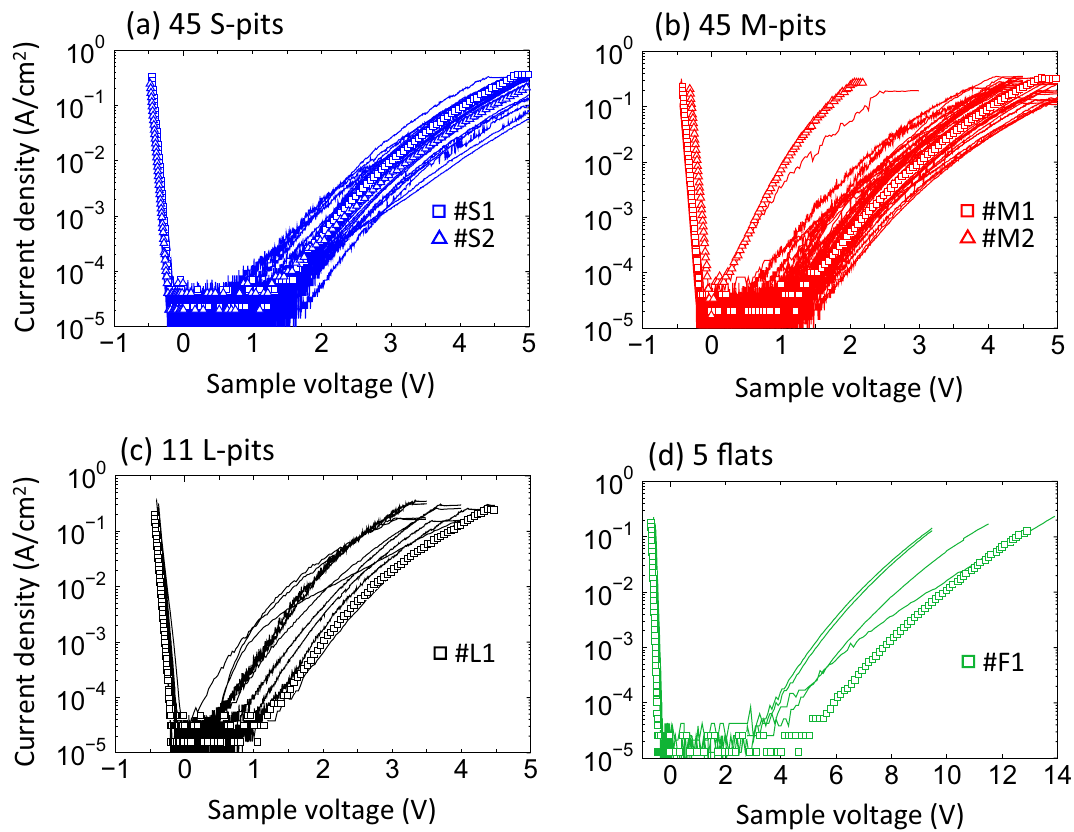
Figure 2. J-V characteristics of ( a ) 45 S-pits, ( b ) 45 M-pits, ( c ) 11 L-pit-type contacts, and ( d ) 5 flat-type contacts as determined under vacuum at 293 K. The symbol plots indicate the Schottky contacts for which I-V-T measurements were also